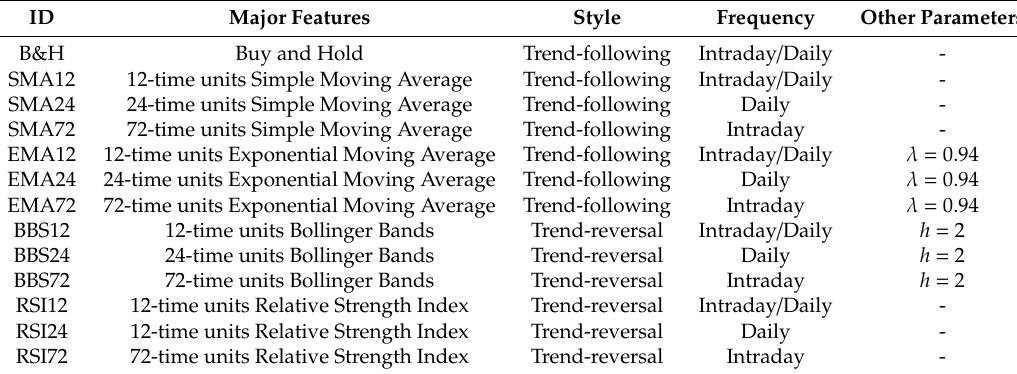
Table 2. TA tools and related nomenclature.